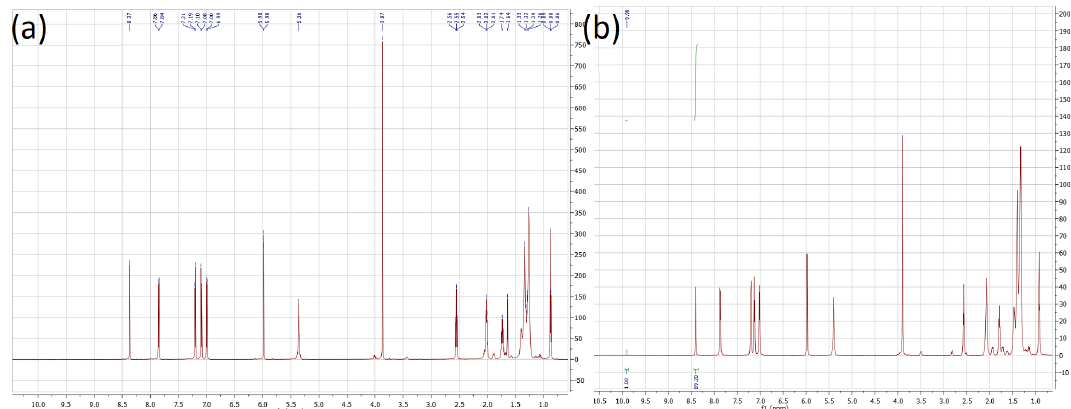
Figure 1. 1 H-NMR of (4-methoxybenzylideneamino)phenyl oleate at 305 K ( a ) and 365 K ( b ).